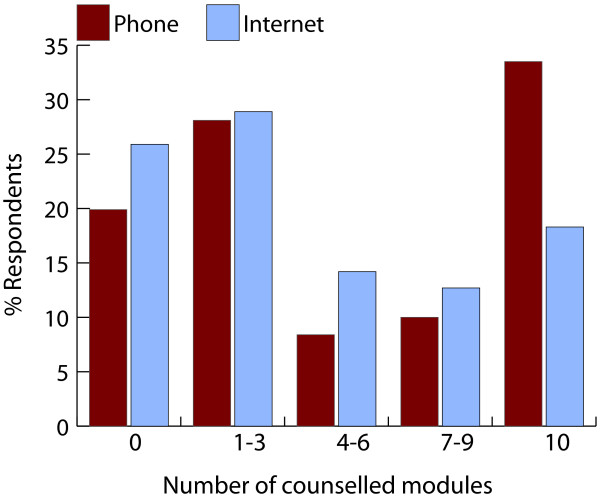
Participation in the intervention. The columns represent the proportions of participants in the phone and internet groups that did not receive any counselling (0) or that were counselled on 1–3, 4–6, 7–9 or 10 modules.